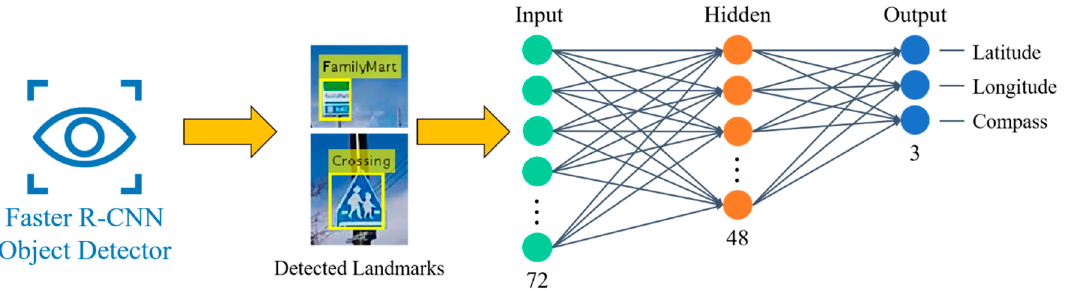
Figure 3. Feedforward neural network (FFNN) for localization with detected landmarks from Faster R-CNN.